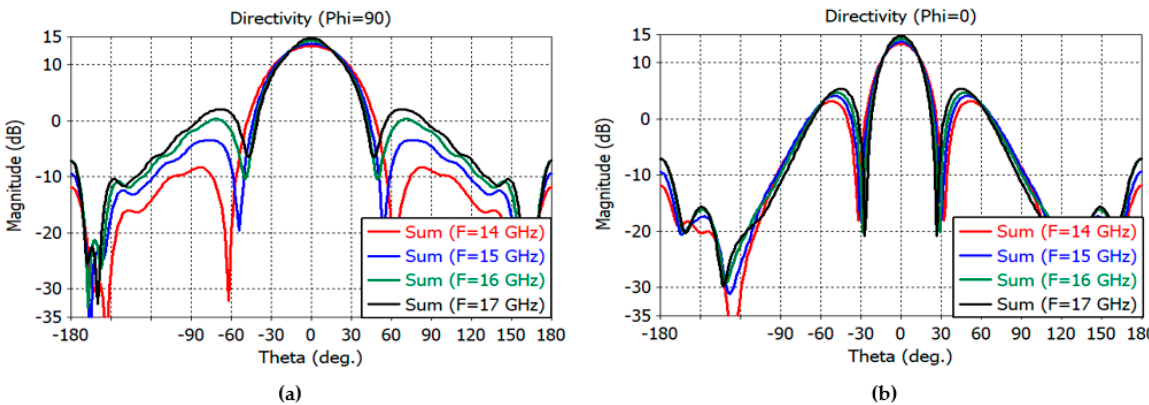
Figure 4. ( a ) E -plane directivity patterns of the sum channel. ( b ) H -plane directivity patterns of the sum channel.